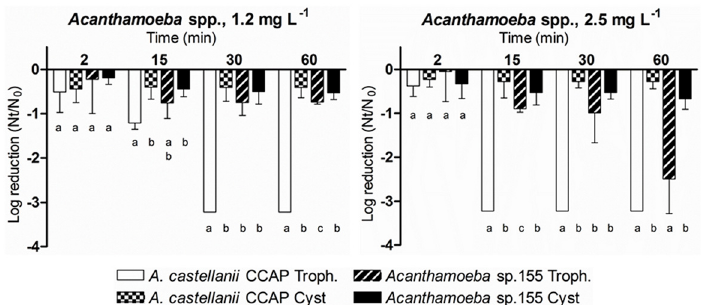
Fig 2. Effect of free chlorine, 1.2 mg L -1 and 2.5 mg L -1 , on the inactivation of 2 Acanthamoeba strains treating separately trophozoites and cysts. Amoebal inactivation was determined using an adaptation of the MPN method. Data are presented as means ± SD (columns and error bars; n = 3). Statistical differences between means within each time point were represented assigning different letters to the bar plot. The same letter was assigned to bars with no significant differences between them. Statistical analyses were performed by ANOVA and pairwise Fisher ’ s LSD test ( p < 0.05).